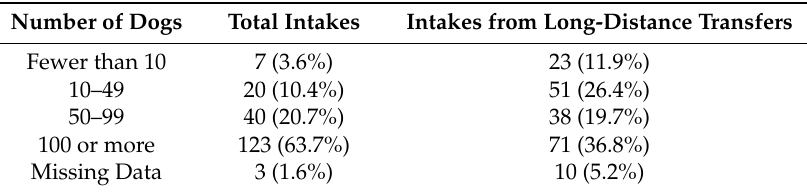
Table 2. The number of organizations belonging to each “number of dogs” category according to their total annual intakes of dogs and their total annual intakes of dogs from long-distance